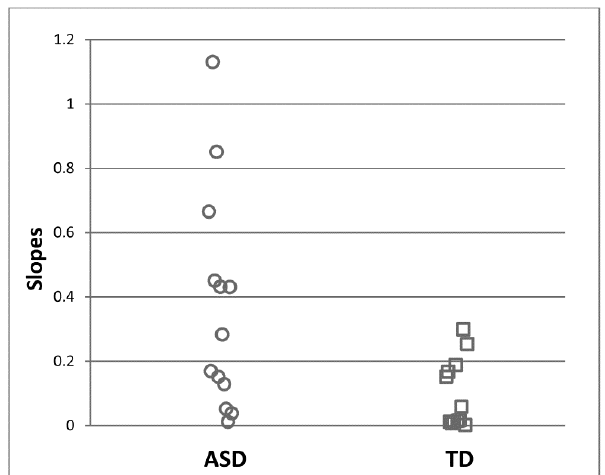
Figure 3. 44% of ASD participants showed greater spectral power increases over contrast manipulation of the visual stimuli than any TD participant. Linear slopes for individual EEG responses across increasing visual contrast were estimated. From Takarae et al. 2016 [63], with